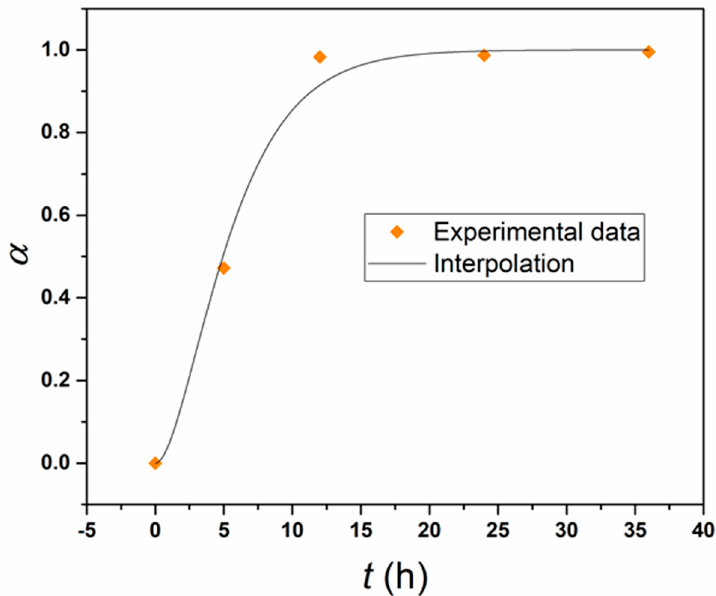
Figure 9. Fraction of LiBH 4 phase obtained by milling LiBO 2 plus Mg-Al-based waste, as a function of time (h).